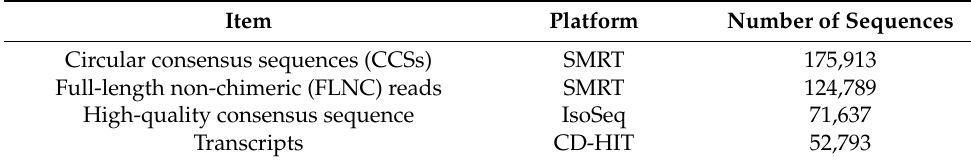
Table 1. PacBio SMRT sequencing data